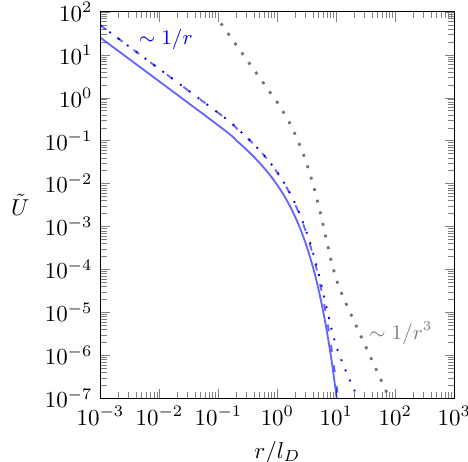
Figure 3. Scaled interaction energy ˜ U = ( 4 π(cid:101) 0 (cid:101) l l D / q 1 q 2 ) × U between two point charges q 1 and q 2 that are both attached to the same interface ( d 1 = 0 and d 2 = d ) as function of the scaled separation r / l D for w = − 78/82. The blue lines correspond to d → ∞ (dotted line), d = l D (dashed line), and d → 0 (solid line), all calculated according to Equation (6). The gray dotted line is Hurd’s [32] decomposition specified in Equation